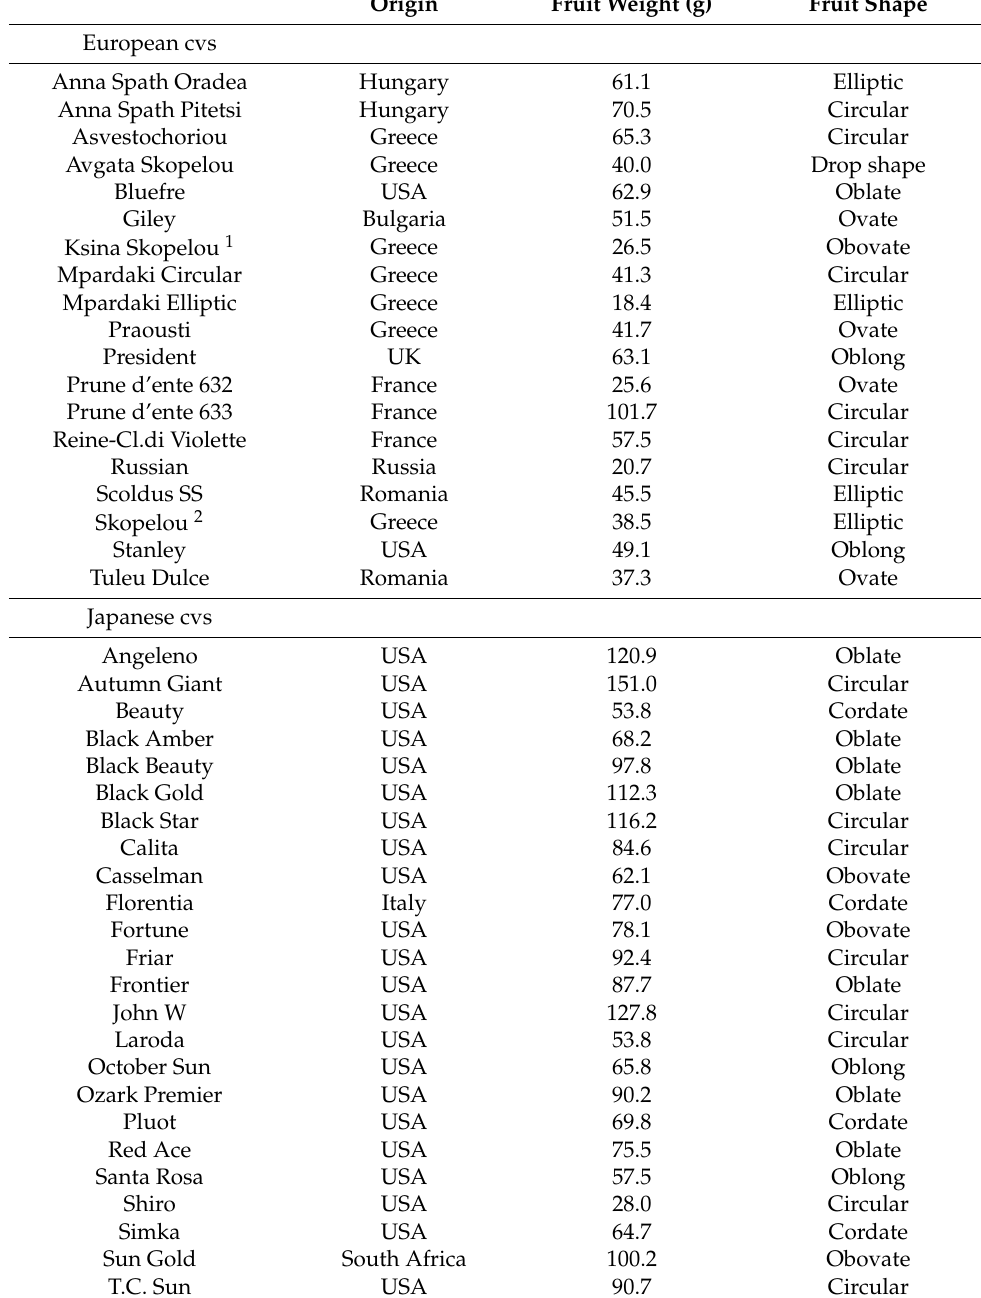
Table 1. Cultivar names, origin, fruit fresh weight, and fruit shape in lateral view (UPOV characteri- zation) of the European and Japanese plum cultivars